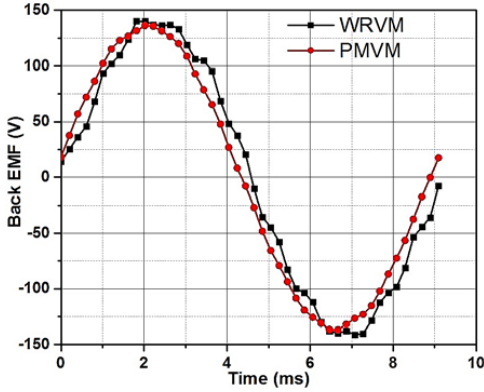
Figure 15. Back EMF comparison.